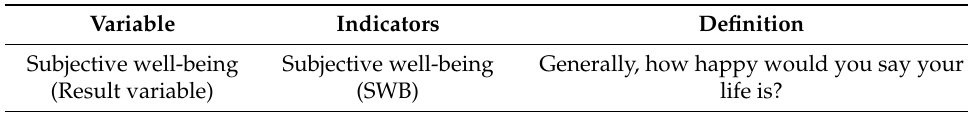
Table 1. Description of variables, metrics, and